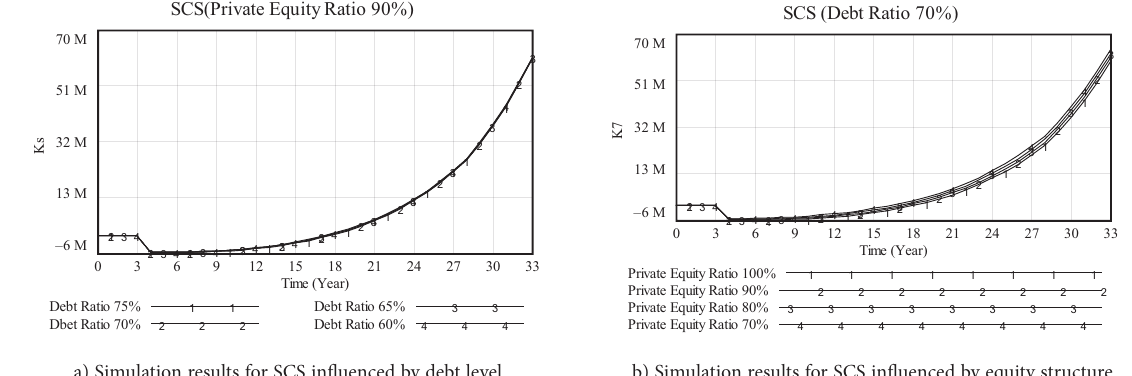
Figure 9. Simulation results for SCS influenced by different financing strategies (two-dimension)